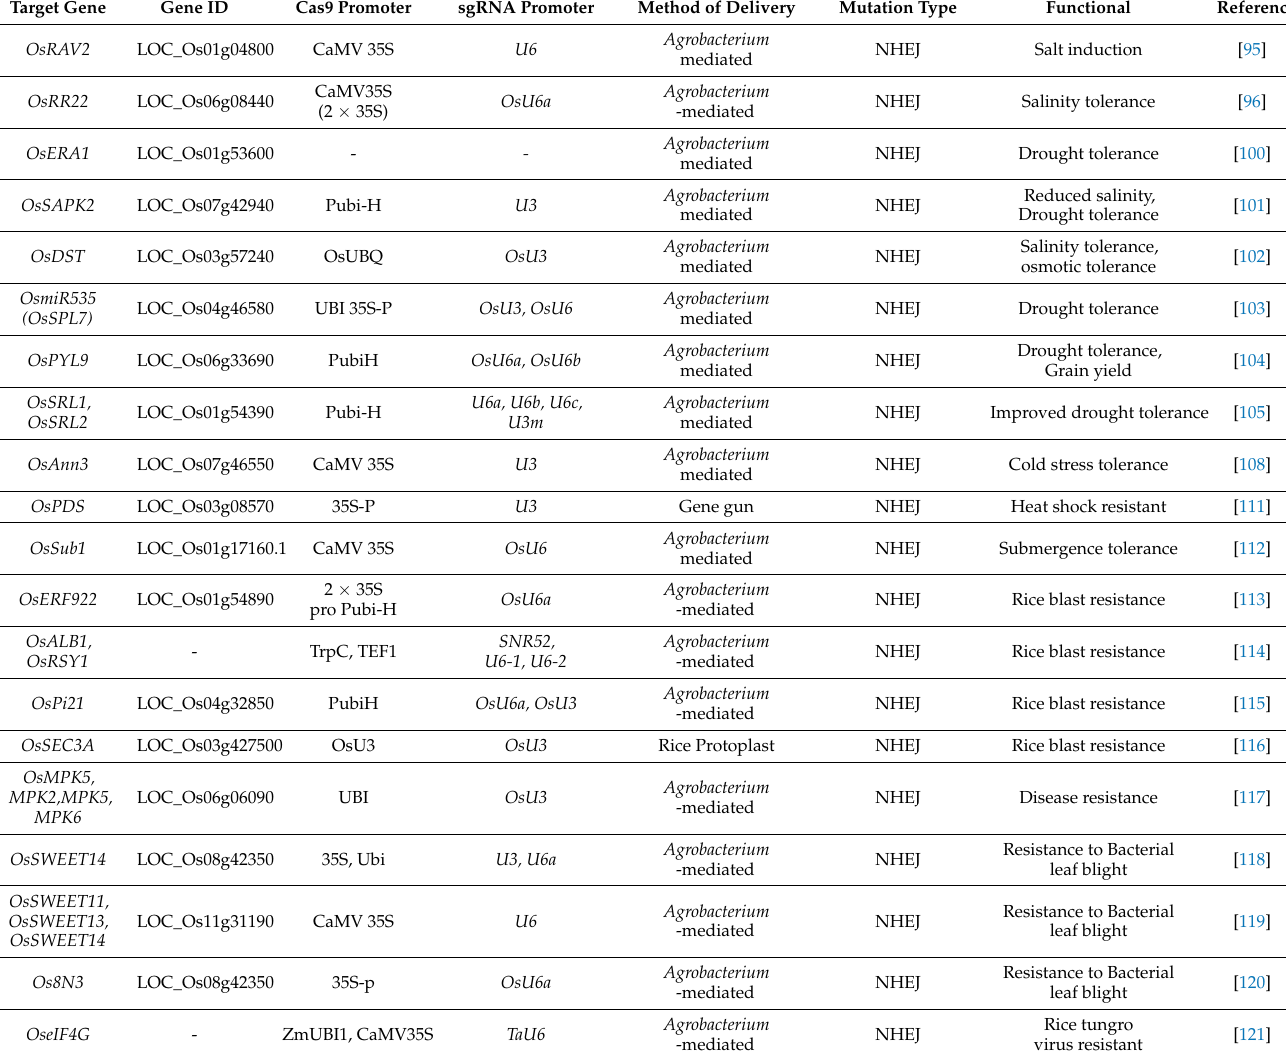
Table 2. Application of CRISPR/Cas9 system to increase abiotic and biotic stress tolerance in rice. Mutation Type